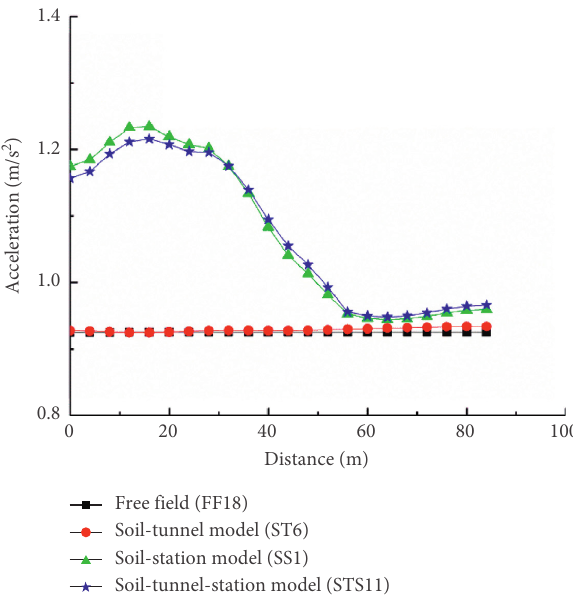
Figure 8: Surface acceleration amplitude under El-Centro wave.